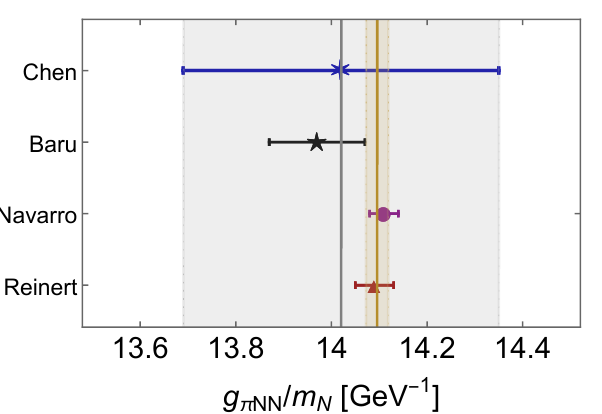
Figure 16. Comparison of the CSM prediction for g π NN / m N (blue asterisk) [275] with values ex- tracted from pion–nucleon scattering [351] (Baru) (black star), the Granada 2013 np and pp scattering database [352] (Navarro) (purple circle), and nucleon–nucleon scattering [353] (Reinert) (red triangle). The vertical grey band marks the estimated uncertainty in the CSM prediction. The error-weighted average of the depicted results, Equation (37), is drawn as the gold line within the like-coloured